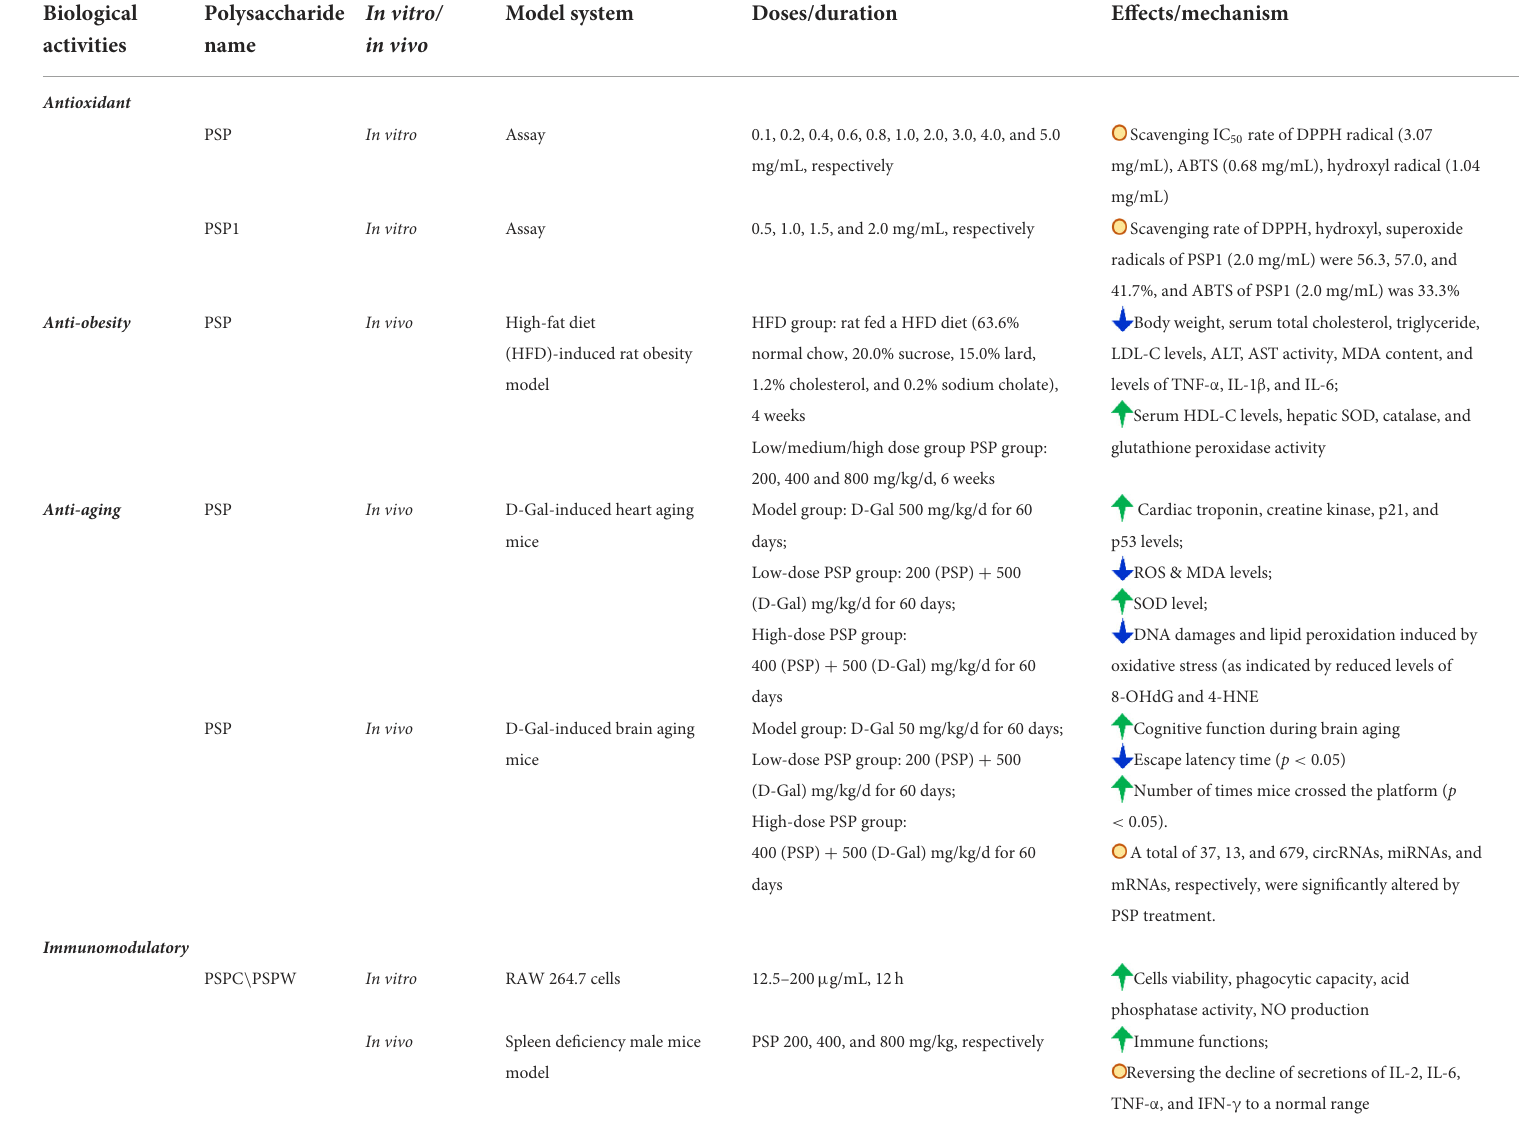
TABLE 2 Representative bioactivities of Polygonatum sibiricum